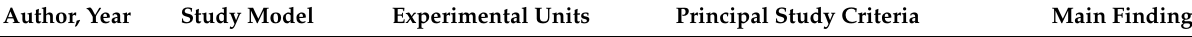
Table 6. Characteristics of the in vivo and in vitro experimental studies selected for the scoping